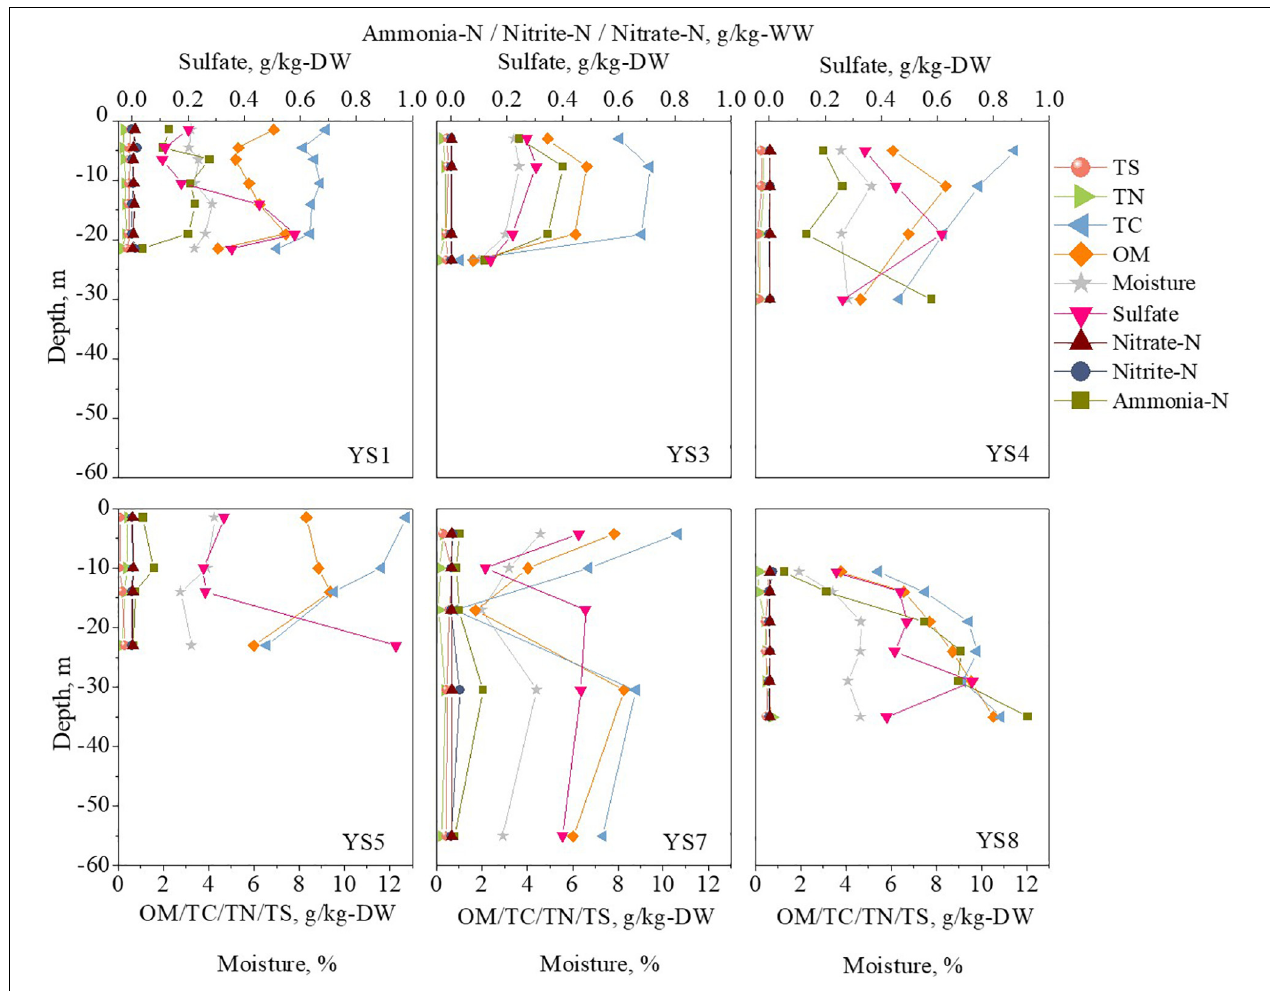
FIGURE 3 | The vertical profiles of environmental factors (Data were shown in Supplementary Table S2